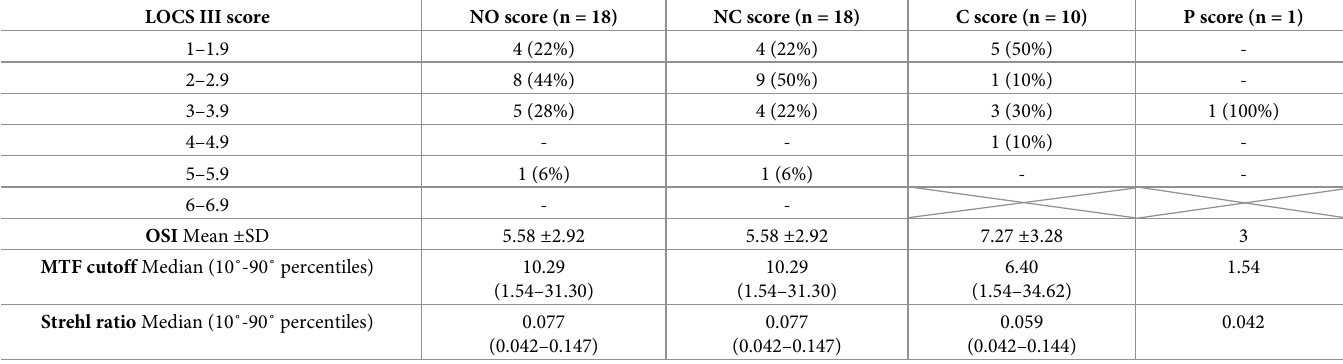
Table 2. Lens Opacification System III scores distribution, mean values and standard deviation of OSI, median values and percentiles of MTF cutoff and of Strehl ratio (n = 21 eyes). LOCS III